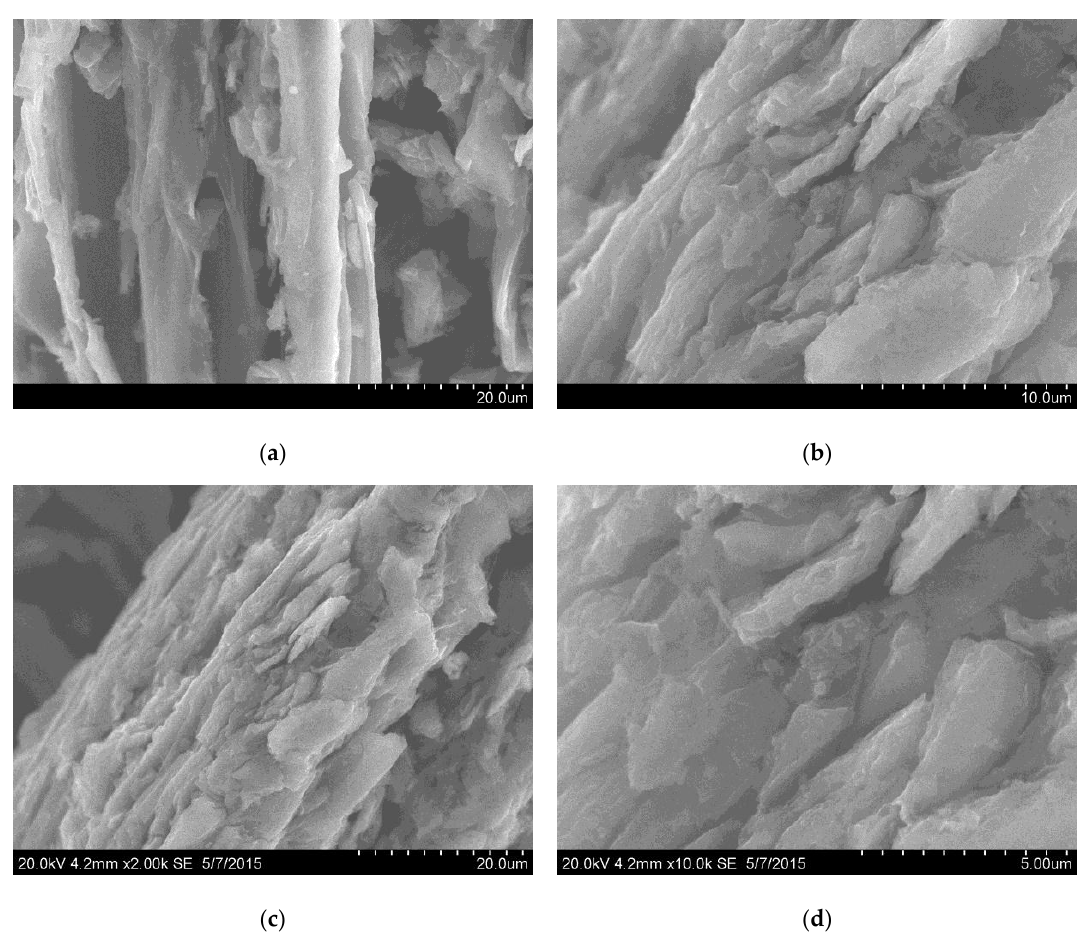
Figure 2. SEM images of GO sample at different magnifications ( a )—x2000; ( b )—x5000; ( c )—x2000; ( d )—x10,000). Particles of micron size are covered by platelets of GO due to strong acidic treatment.